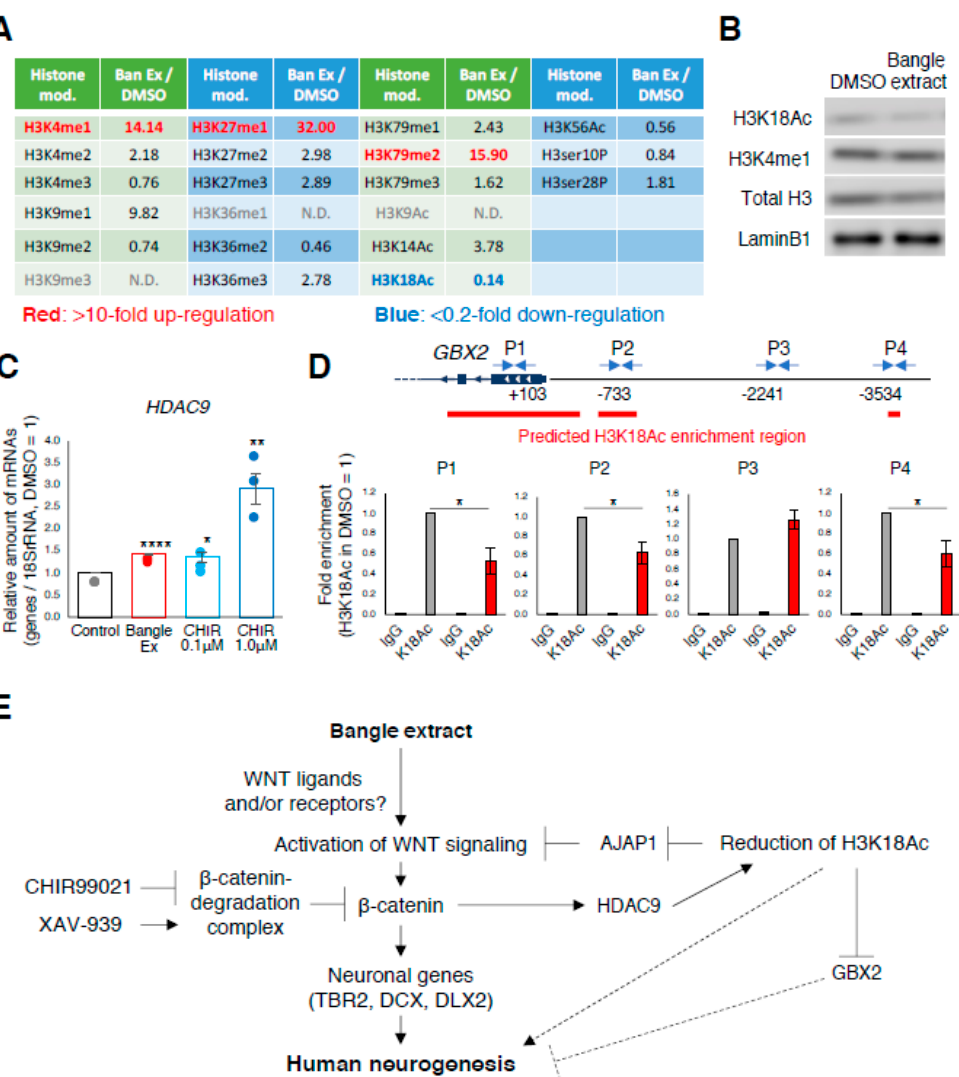
Figure 5. Bangle extract affects histone modifications during neuronal differentiation. ( A ) The cells were treated with 10 ng/mL Bangle extract for 2 days during the induction of neuronal differentiation. Equal amounts of nuclear protein were added among samples in the experiment. Each histone H3 modification is presented as a ratio normalized to DMSO-treated controls. ( B ) Western blot analysis of nuclear H3K18Ac expression in Bangle extract-treated (10 ng / mL) hfNSCs. ( C ) Quantitative RT-PCR analysis of the cells 2 days after the induction of differentiation. Data represent mean ± SEM, when compared to control cells. ( N = 3, t -test, * p < 0.05, ** p < 0.01, **** p < 0.001). Colored dots represent the value from individual experiments. ( D ) ChIP assays for hfNSC at 2 days after induction of differentiation were performed using anti-H3K18Ac antibody, and control IgG, followed by real-time PCR with the primer sets in the proximity of GBX2 gene. The relative amounts are the means ± SEM compared with those for H3K18Ac in DMSO treatment. ( N = 3, t -test, * p < 0.05). ( E ) Summary of the promotion of human neurogenesis by treatment of Bangle extract and its active ingredient.